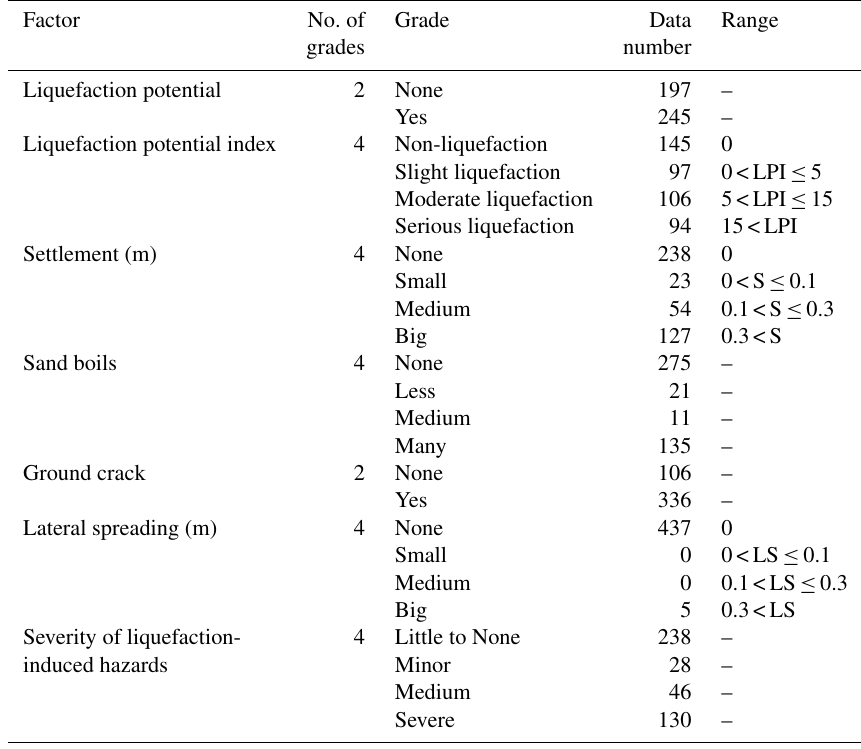
Table 3. Grading standard for liquefaction and liquefaction-induced hazards.